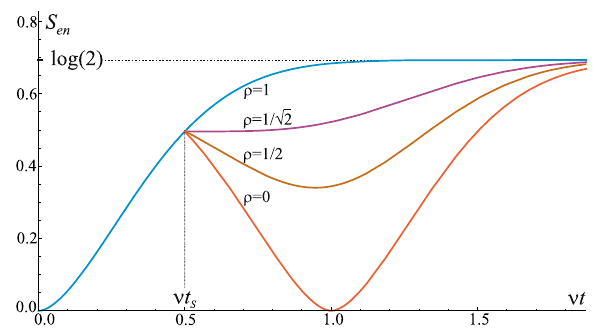
Fig. 3 Entropy of entanglement. Entropy S en is plotted dependent on time t for different values of ρ with E J / ℏ ω = 1.4. For t s < t < t s + T , = const (not shown in the fi S en